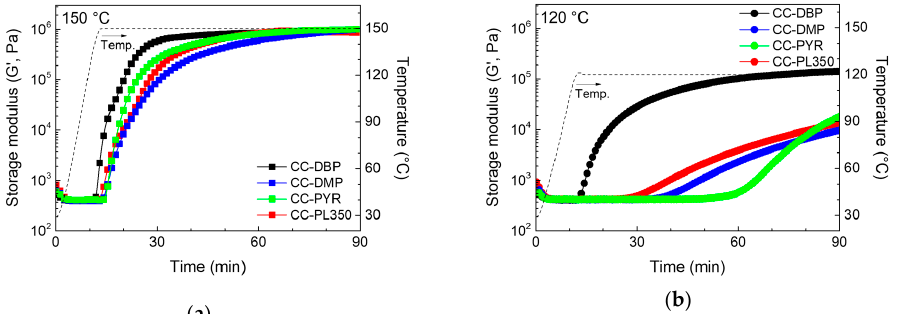
Figure 3. Real-time storage modulus data of clearcoat samples measured at two different temperatures: ( a ) 150 °C and ( b ) 120 °C.